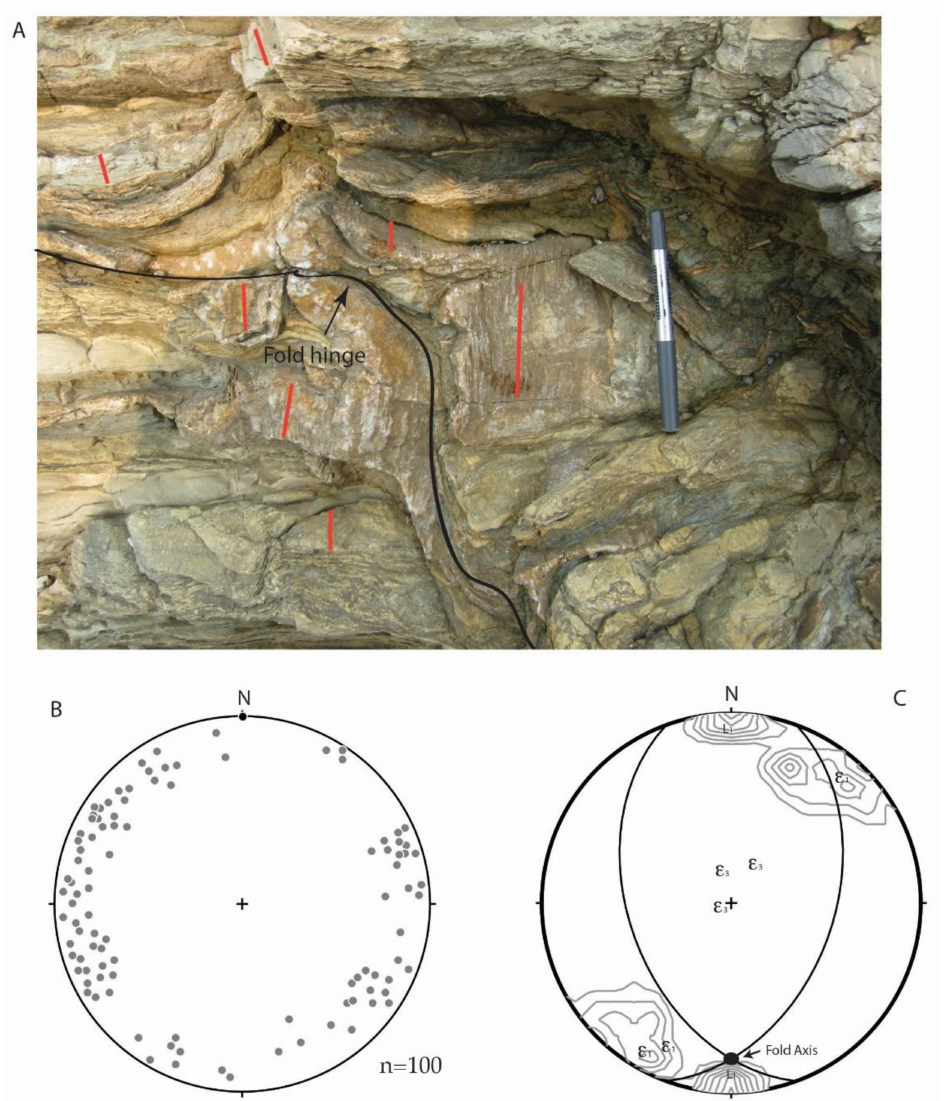
Figure 3. Oblique view down at the fold hinge showing the striated calcite parallel to the fold axis ( A ; pen for scale). Lower hemisphere projection of the combined optic axis data ( B ) and the limb-hinge-limb strain data (Table 1) where great circles are bedding planes for the fold that plunges 20 ◦ south ( C ). Fold axis-parallel lineations are contoured, as are Turner [26] compression axes. Shortening ( ε 1 ) and extension ( ε 3 ) strain axes were plotted for the three